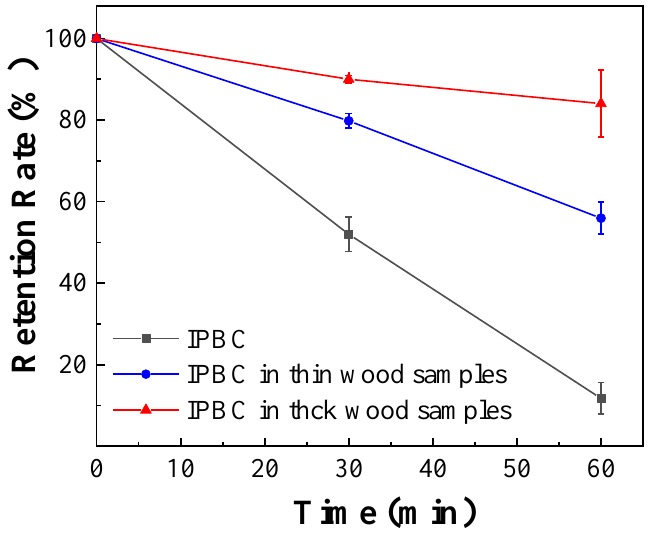
Figure 7. Thermal degradation of IPBC in wood samples at 140 °C.